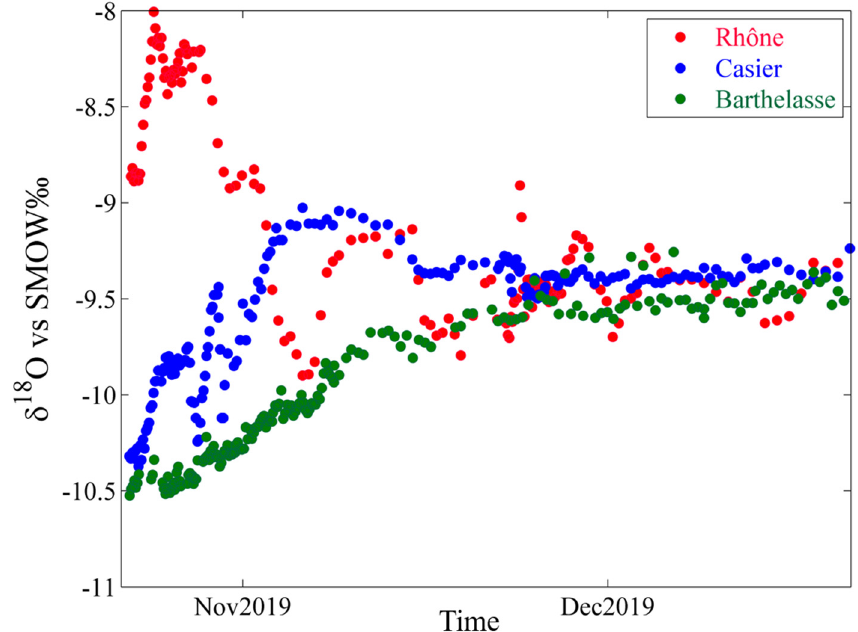
Figure 10. δ 18 O evolution in the Rhône, backfill and Barthelasse during flood monitoring.